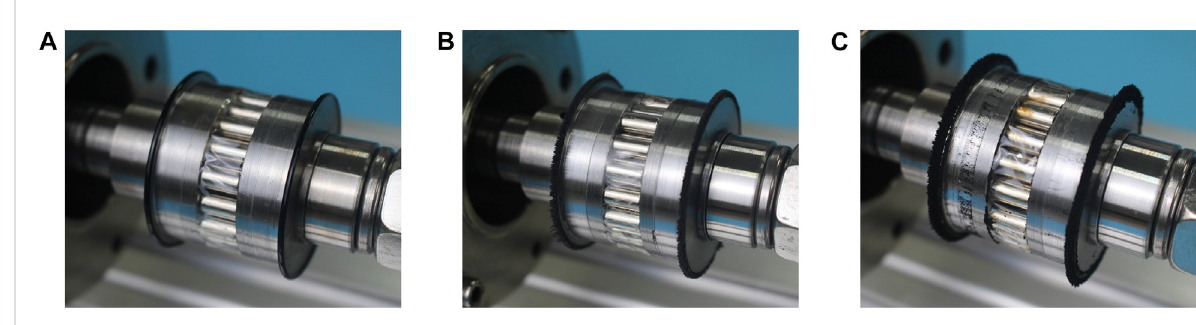
valves, a computer, etc. During one experiment, a pair of pole pieces are fi rst assembled on the shaft. The magnetic medium is injected or smeared on each pole tooth circularly, as is shown in